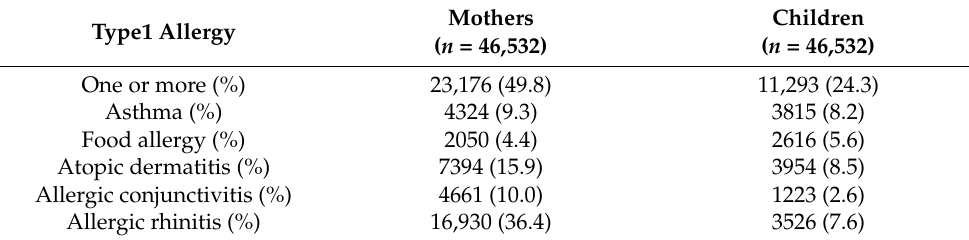
Table 1. Profile of the